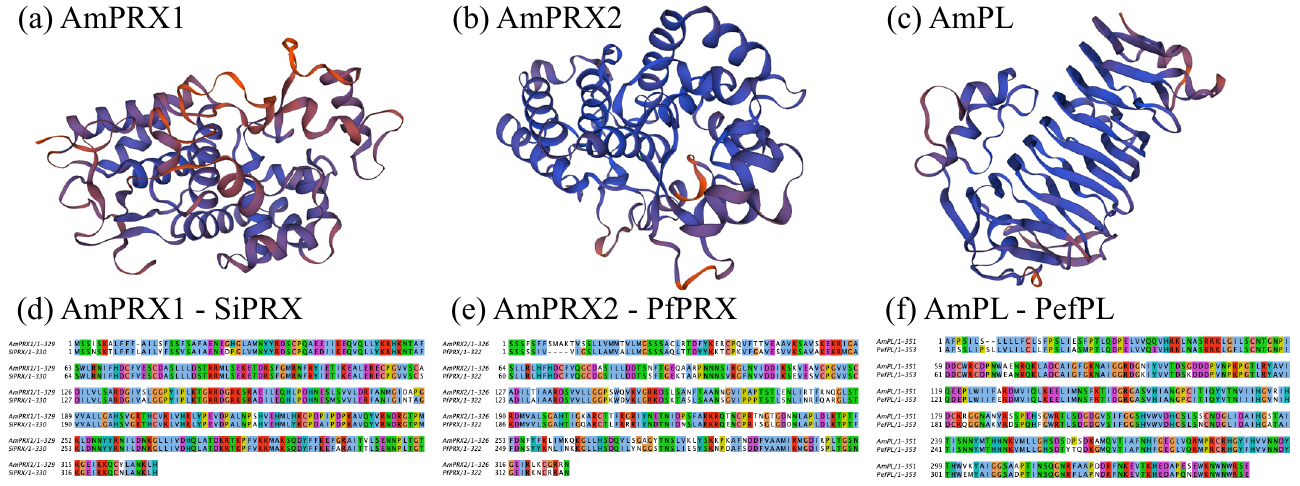
Figure 2. Three ‐ dimensional models of AmPRX1 ( a ), AmPRX2 ( b ), and AmPL ( c ) proteins and align ‐ ment AmPRX1 and SiPRX ( d ), AmPRX2 and PfPRX ( e ), AmPL and PefPL ( f ). The protein models were constructed by molecular modeling in SWISS ‐ MODEL. Color represents the estimated per ‐ residue inaccuracy (blue and red indicate more reliable and potentially unreliable regions, respec ‐ tively). 3.2. Spatial Expression of AmPRX1, AmPRX2, AmPL, and AmPSK Genes in Avicennia marina Furthermore, the organ ‐ specific expression patterns of AmPRX1 , AmPRX2 , AmPL , and AmPSK genes in A. marina under normal conditions were analyzed via RT ‐ qPCR.